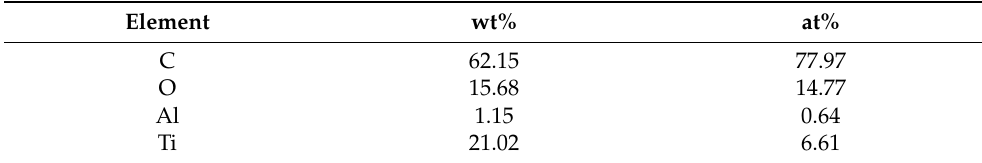
Figure 9. The mapping elements scanning results of the interface at speed of 10 mm/s. Table 3. Element content of spot A in Figure 9. Table 3. Element content of spot A in Figure 9.